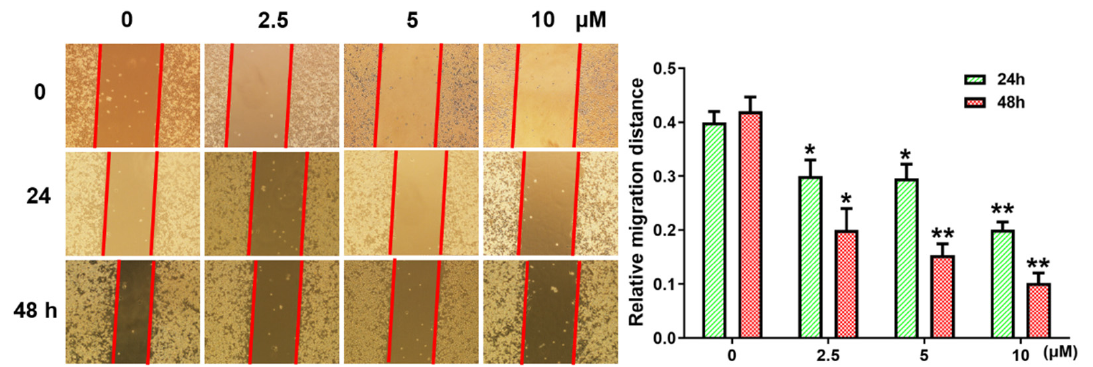
Figure 2. Wound healing assay to HepG2 cells treatment with DMEM medium containing the indi- cated concentrations (0, 2.5, 5, 10 µ M) of B5 for 24 h and 48 h. Data are represented by the mean ± SD of the three independent experiments. ** p < 0.01, * p < 0.05, compared with the 0 µ M